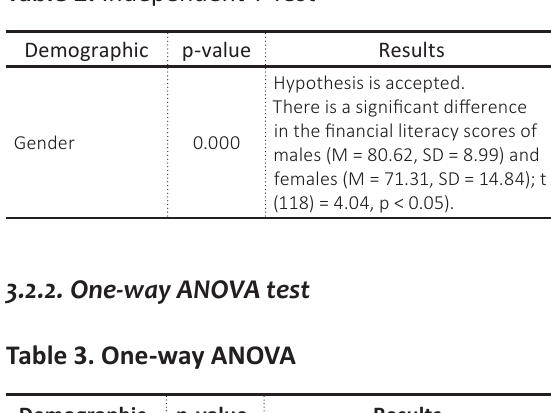
Table 2. Independent